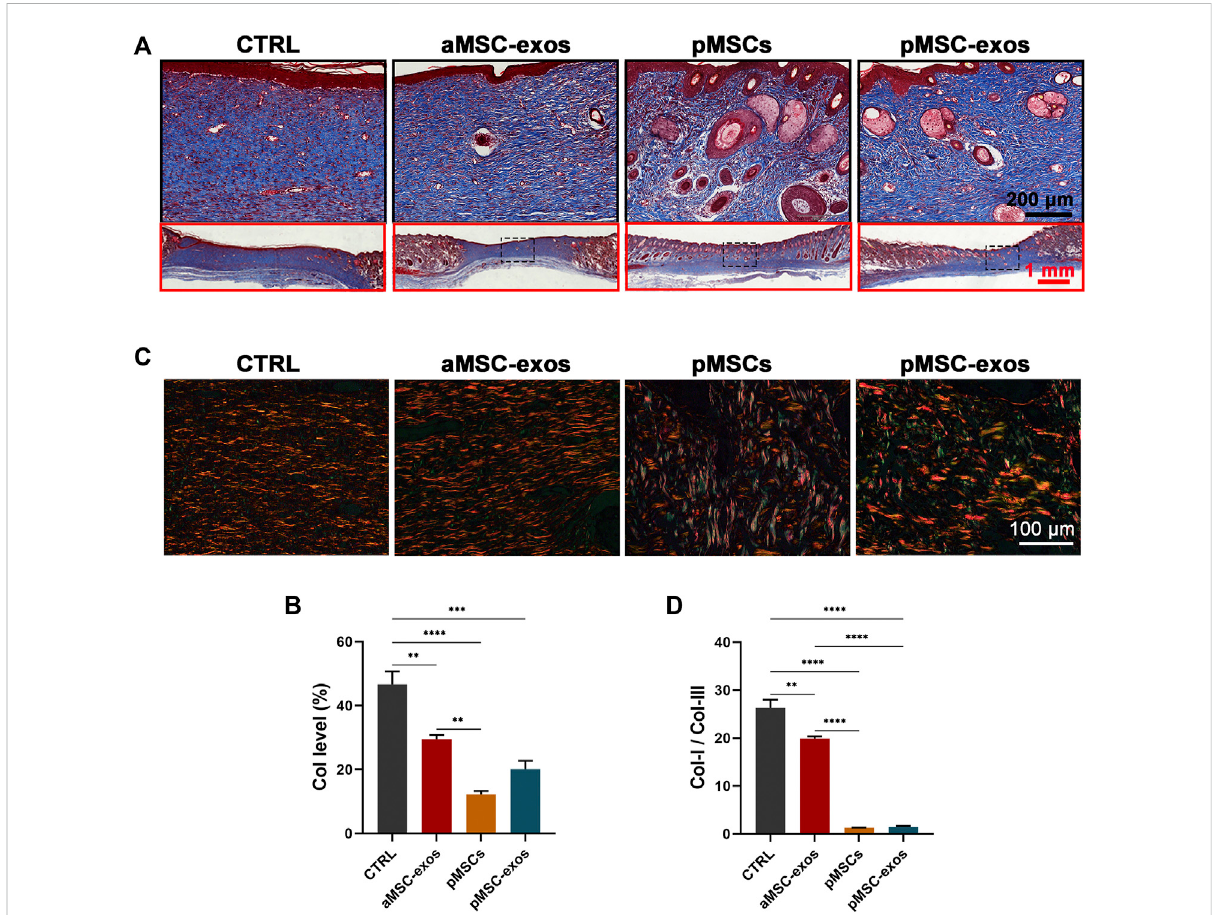
FIGURE 4 pMSC-exos regulate the structure and composition of collagen in wound healing. (A) Masson staining of the healed skin. (B) Accounts of collagen fi bers(bluearea)inthehealedskinaccordingtoMassonstaining. (C) Siriusredstainingofthehealedskin. (D) TheratioofcollagenI(redarea) to collagen III (green area) in the healed skin according to Sirius red staining. Mean ± SEM; ** p < .01, *** p < .001, **** p < .0001; n = 3. Col,